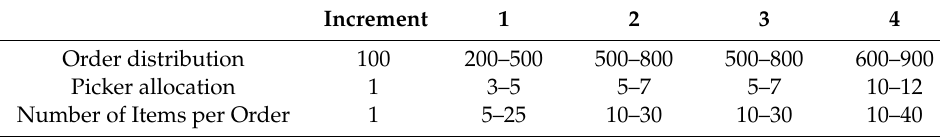
Table 2. Order distribution and picker allocation per